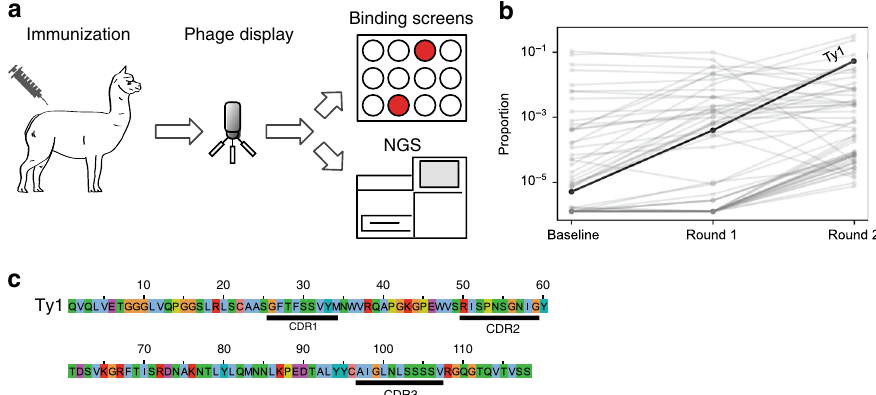
Fig. 1 Nanobody discovery. a Overview of the nanobody generation process. b Variant frequencies quanti fi ed by next generation sequencing (NGS) across successive enrichment steps. Identi fi ed using receptor-binding domain (RBD) bait, Ty1 exhibits the greatest total fold change of all nanobodies, increasing in proportion over 10,000-fold between initial and fi nal libraries. c Sequence of Ty1. Complementarity-determining regions (CDRs) are indicated. Amino acid color labels; hydrophobic, blue; positive charge, red; negative charge, magenta; aromatic, cyan; polar, green; cysteine, pink; glycine, orange; proline,